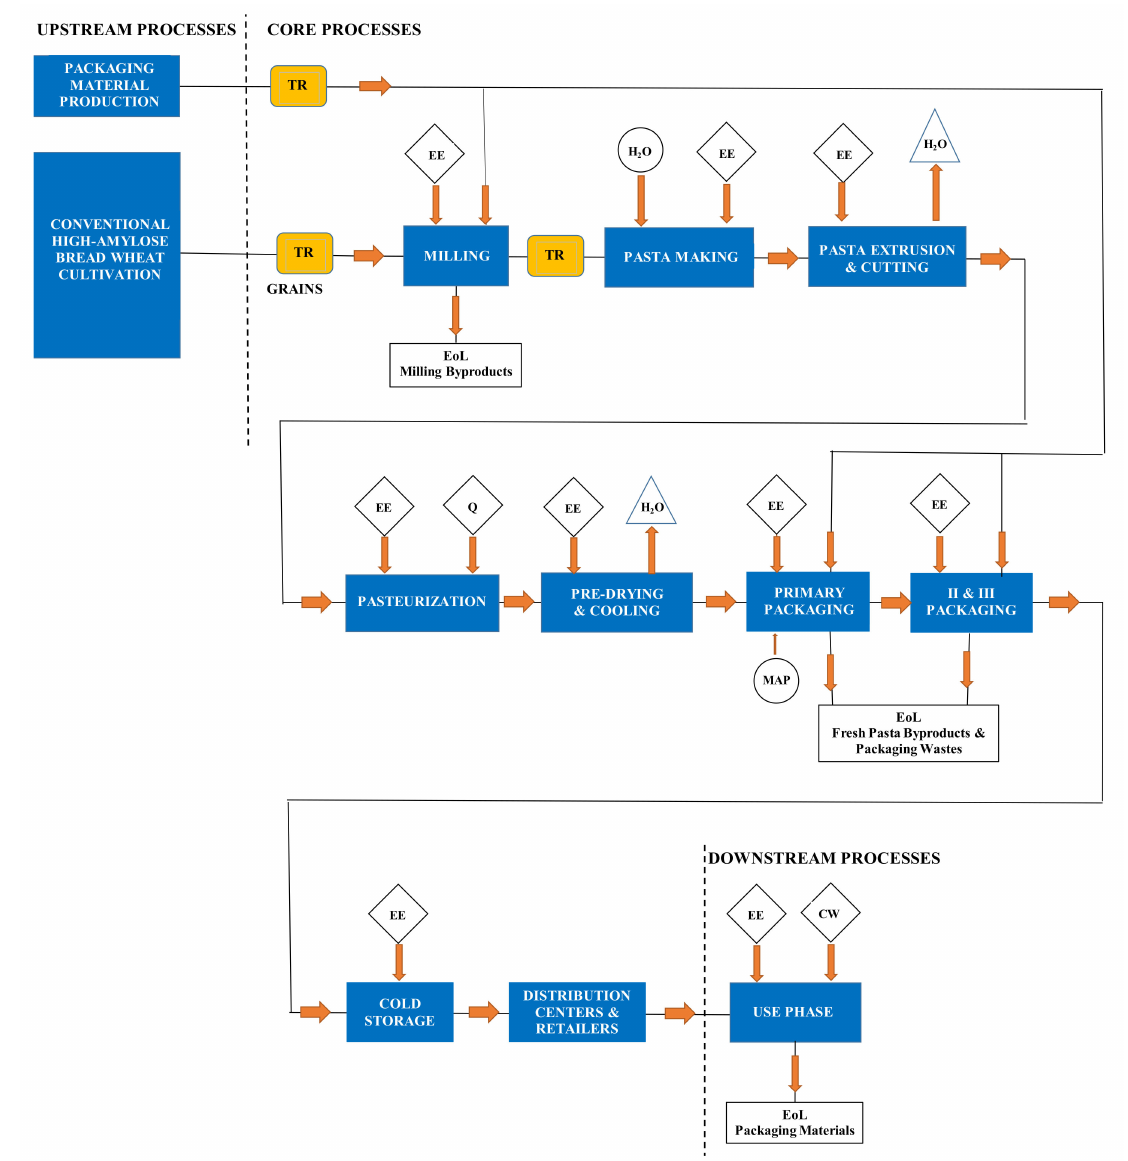
Figure 1. Pasteurized high-amylose fresh pasta system boundary, where the main processes are subdivided into upstream, core and downstream ones: CW, cooking water; EE, electric energy; EoL, end of life; H 2 O, process water; MAP, modified atmosphere packaging; Q, thermal energy; TR,